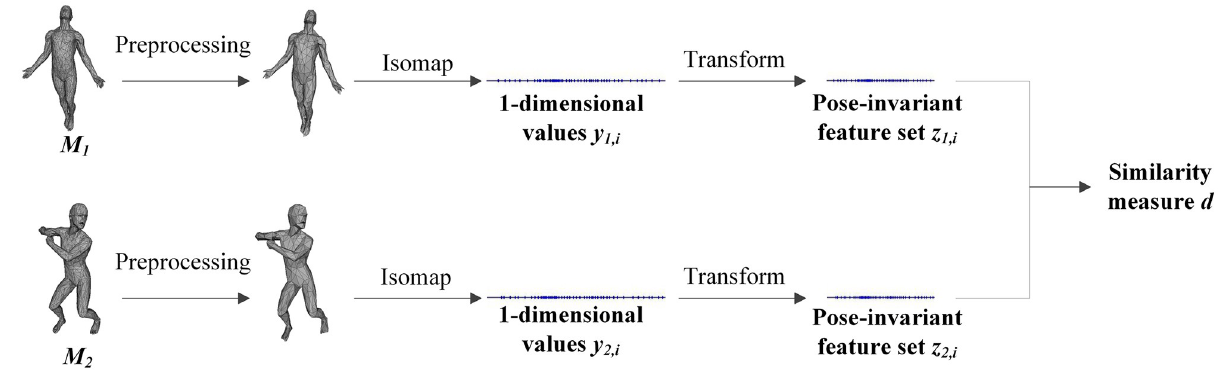
Fig 2. An overview of our